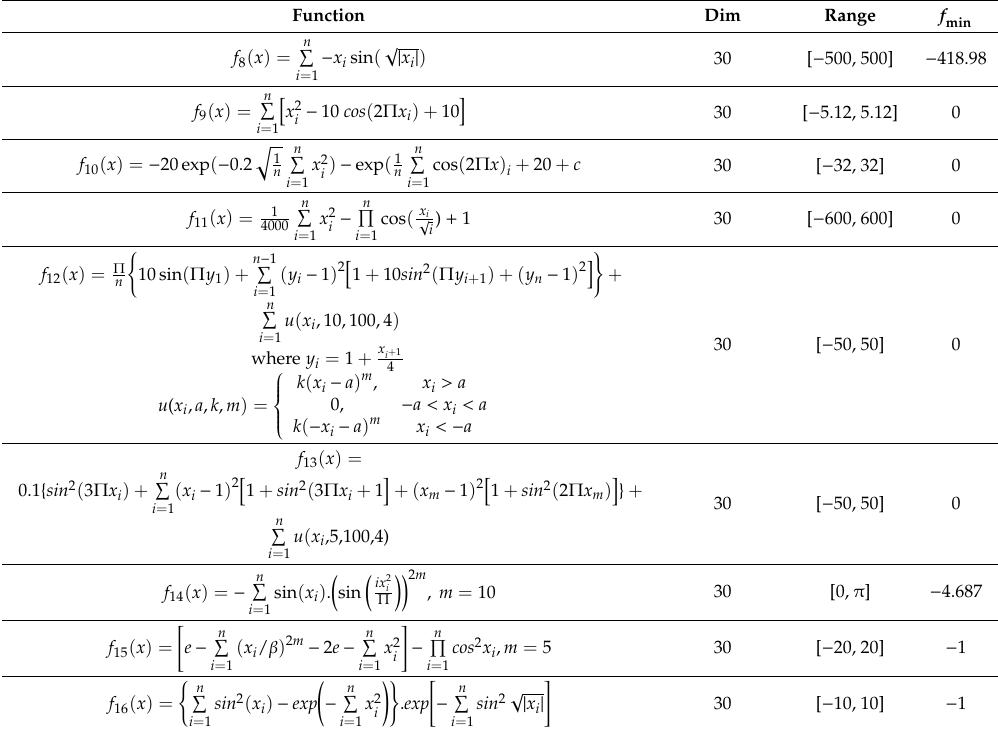
Table 2. Multimodal